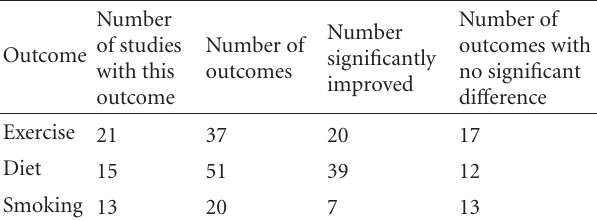
Table 5: Summary of lifestyle risk